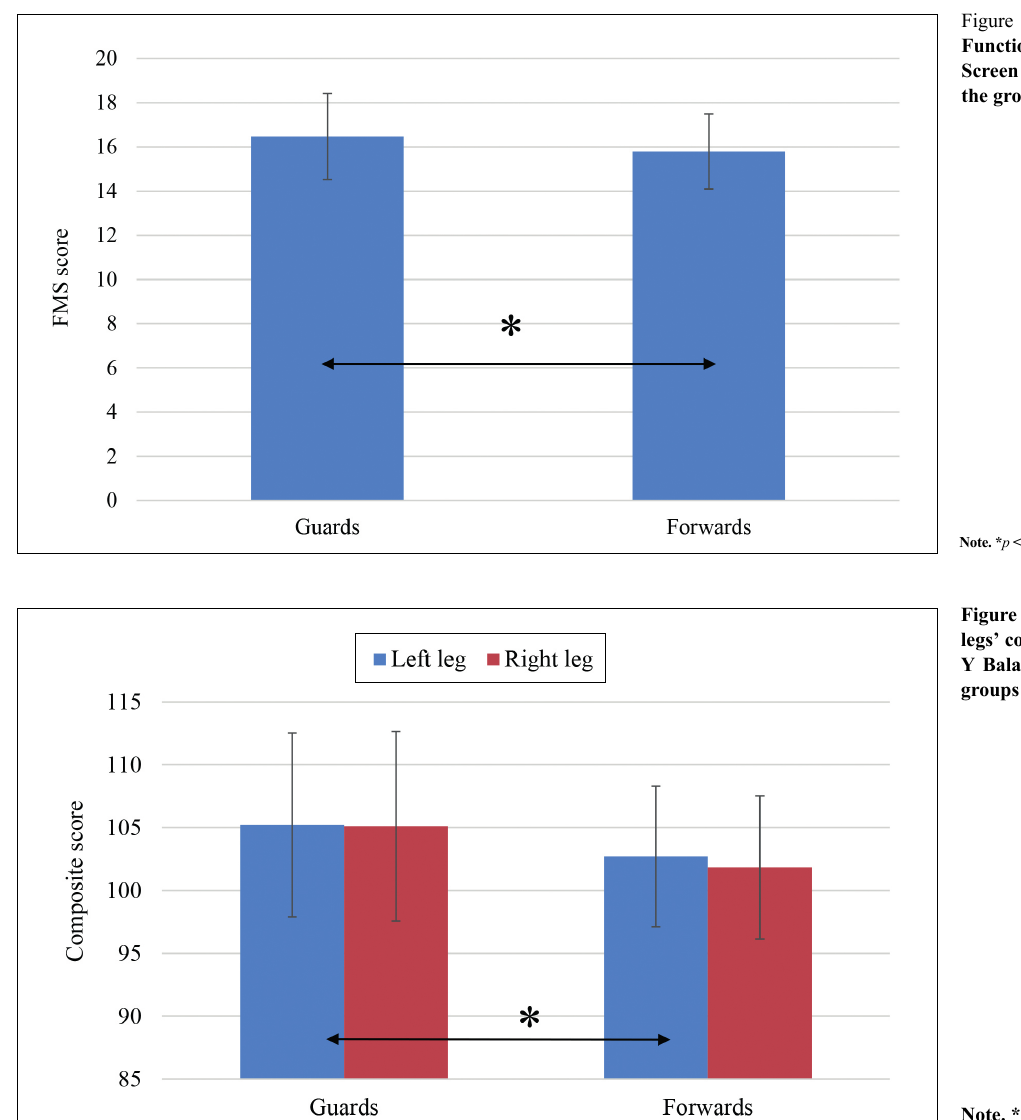
Figure 3. The final Functional